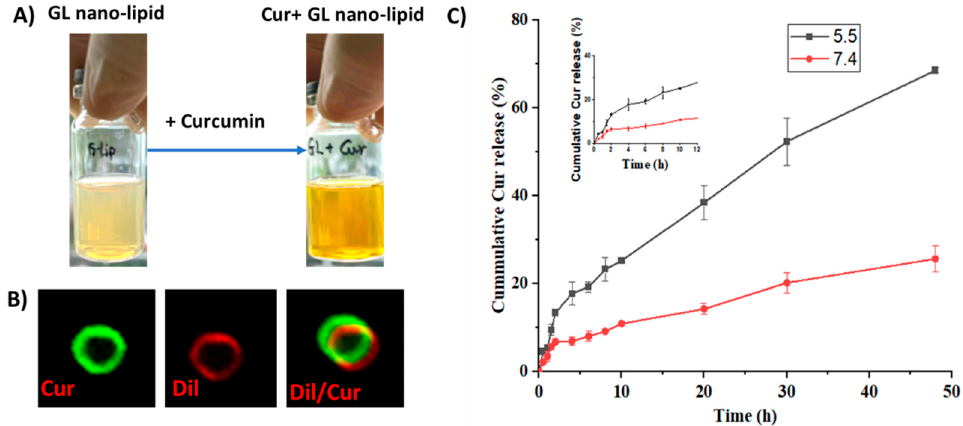
Figure 6. ( A ) Visual observations and confocal microscopy image ( B ) of Cur/GL nano-lipids. ( C ) In vitro release profiles of curcumin from GL nano ‐ lipids at pH 7.4 (red line) and at pH 5.5 (black line) in 37 °C. Data are presented as mean ± SD (n = 3).